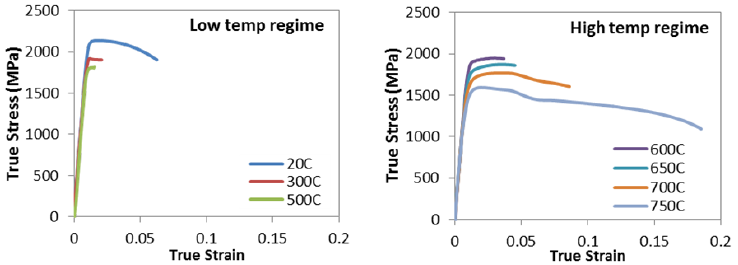
Figure 17. True stress versus true strain measured from tensile tests, with data divided into two distinct